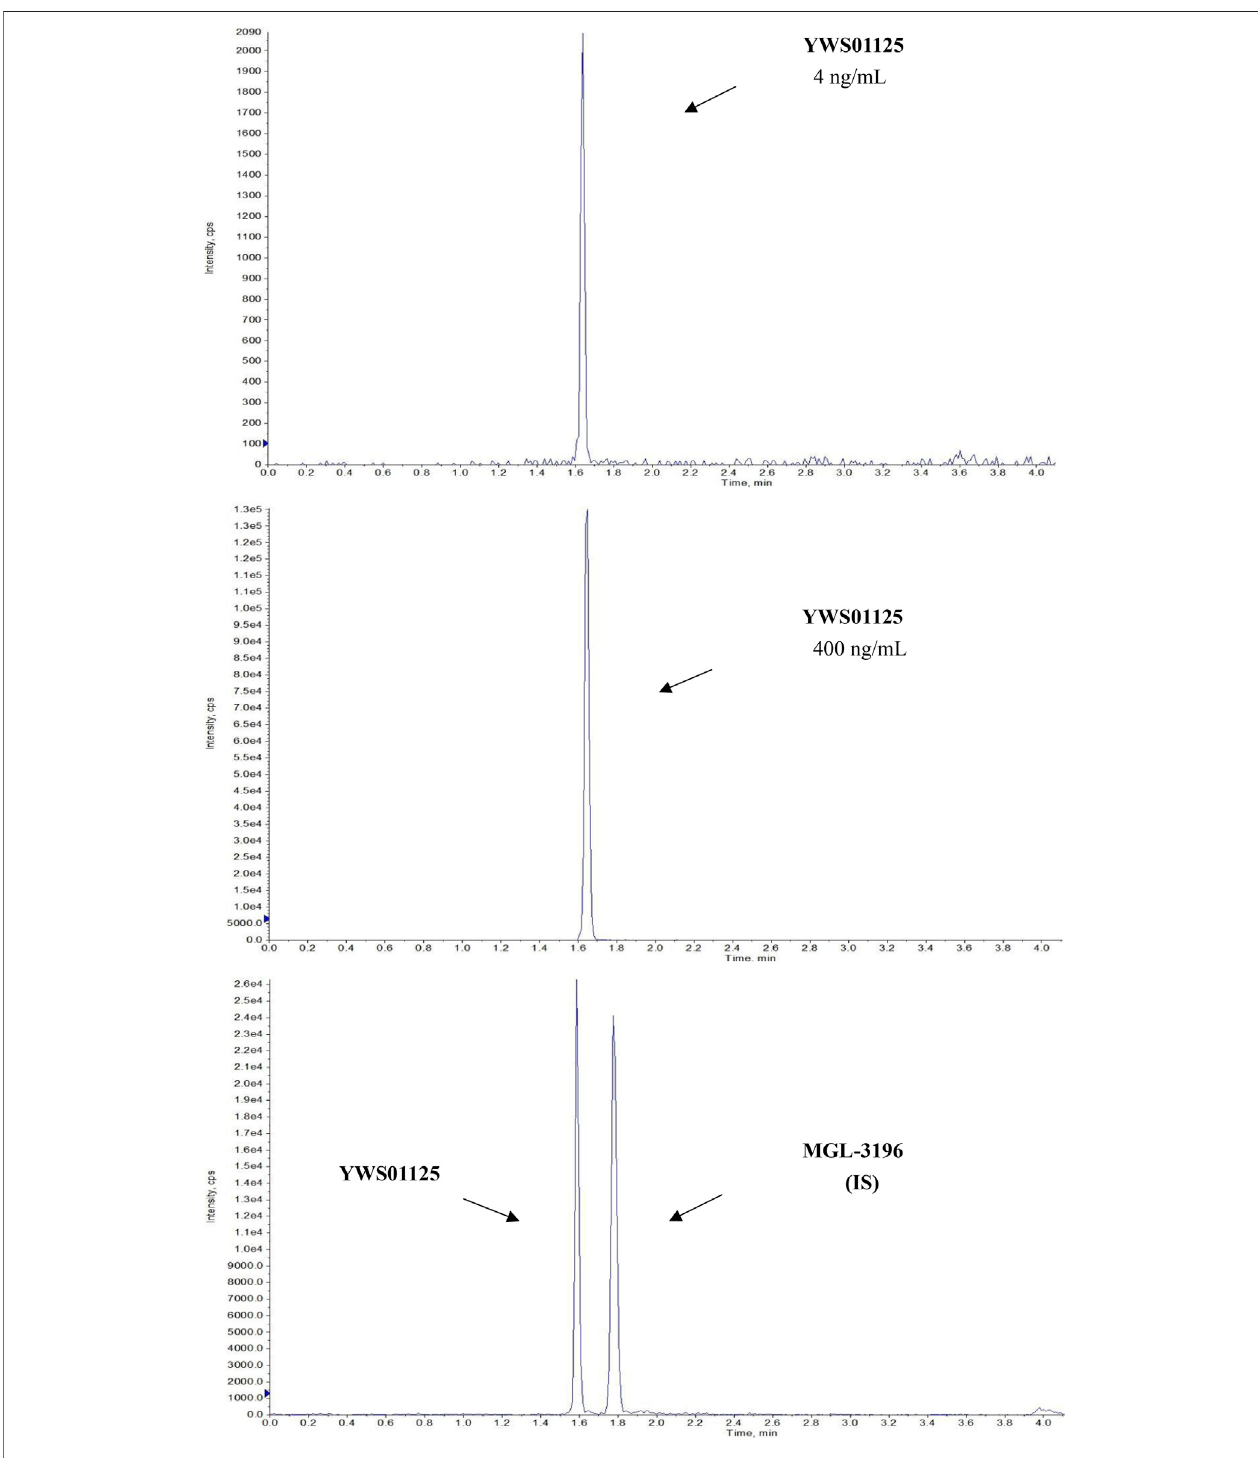
FIGURE 5 | Representative LC-MS/MS chromatograms of YWS01125 (4 and 400 ng/ml) and MGL-3196 (IS) samples.